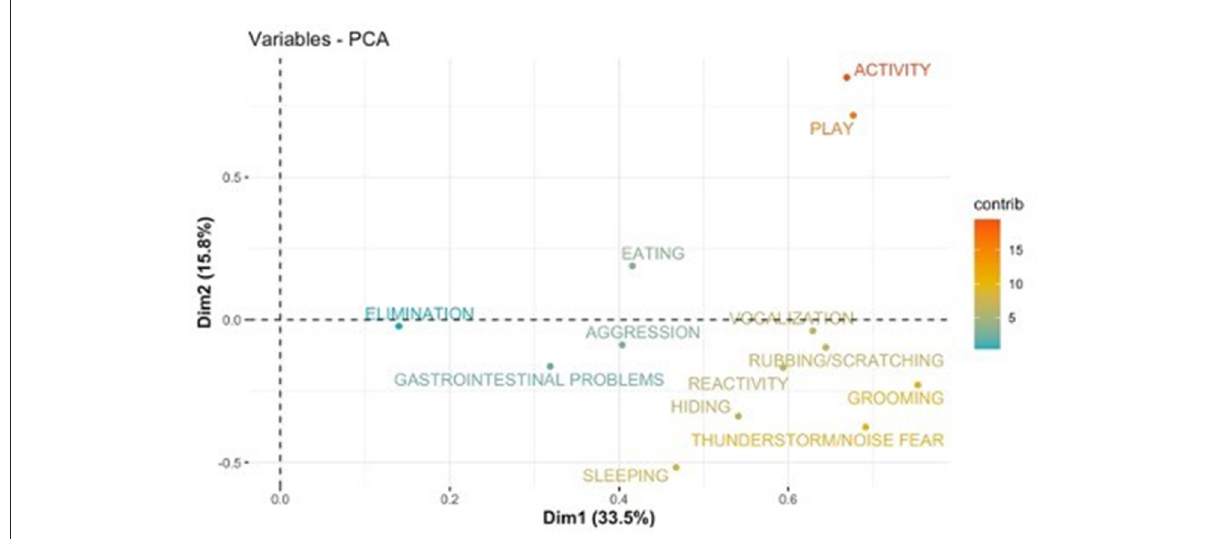
FIGURE6 Loadings plot of the behavioral variables of cats on the first (PC 1) and second (PC 2) principal components with the increase in temperature. The contribution of the variables is colored depending on their importance.